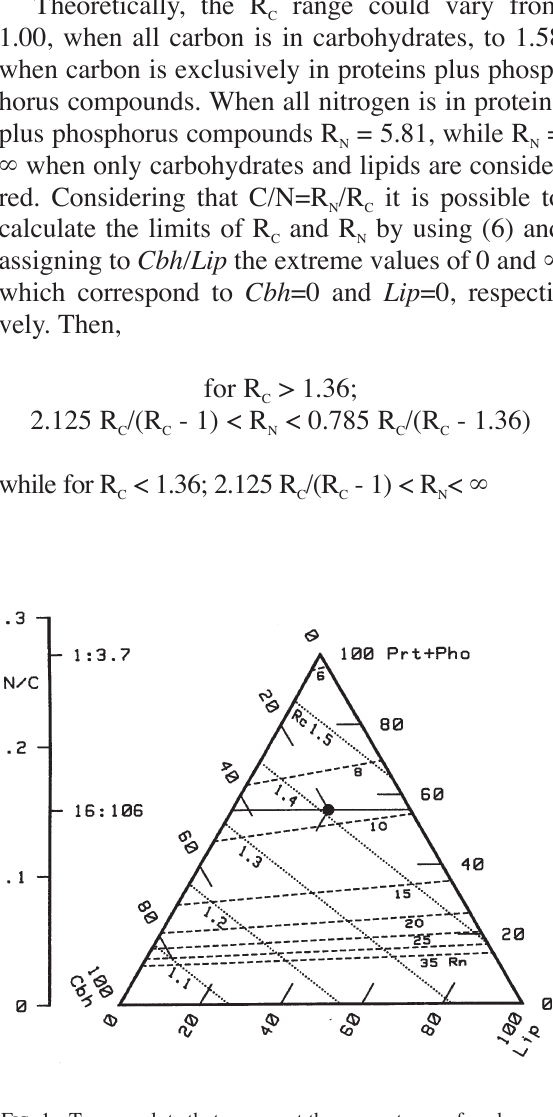
. The dashed lines C